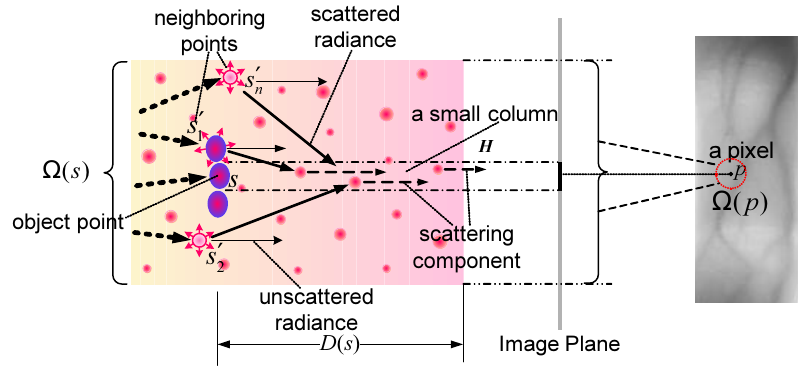
Figure 7. Schematic representation of the effect of scattered